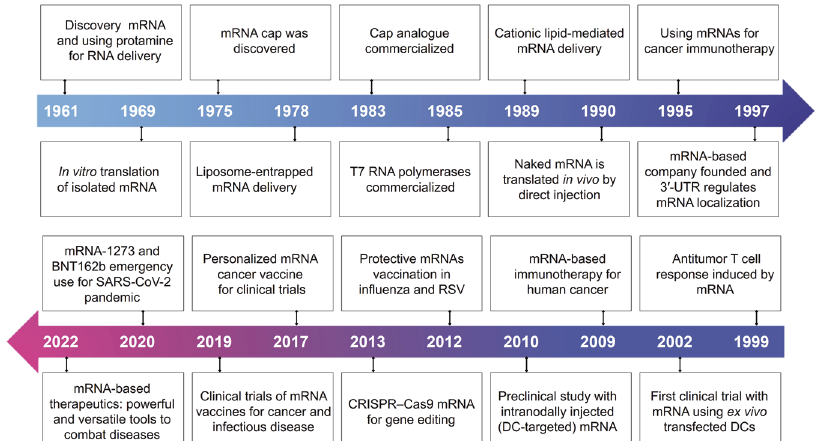
Fig. 1 Key discoveries and advances in mRNA-based therapeutics. The development of mRNA-based therapeutics can be divided into three stages. Phase 1, mRNA discovery, in vitro synthesis and nucleic acid delivery system construction (1961 – 1990), including discovery mRNA 523 and using protamine for RNA delivery, 524 in vitro translation of isolated mRNA, 525 mRNA cap was discovered, 526 Liposome-entrapped mRNA delivery, 527 Cap analog commercialized, T7 RNA polymerases commercialized, Cationic lipid-mediated mRNA delivery, 528 Naked mRNA is translated in vivo by direct injection. 529 Phase2 (1990-2019), accumulated knowledge with the continuous attempts and diverse applications, especially protein replacement therapies and vaccination approaches for cancer and infectious diseases, including using mRNAs for cancer immunotherapy, 5 mRNA-based company founded and 3 ′ -UTR regulates mRNA localization, 530 antitumor T cell response induced by mRNA, 531 fi rst clinical trial with mRNA using ex vivo transfected DCs, 532 mRNA-based immunotherapy for human cancer, 533 preclinical study with intranodally injected DC-targeted mRNA, 534 protective mRNAs vaccination in in fl uenza 240 and respiratory syncytial virus, 98 CRISPR – Cas9 mRNA for gene editing, 535 personalized mRNA cancer vaccine for clinical trials. 330 Phase 3, mRNA-based therapeutics, as a disruptive therapeutic technology, is becoming powerful and versatile tools for therapy diseases (2019 to present), including clinical trials of mRNA vaccines for cancer and infectious disease, mRNA-1273, 536 and BNT162b emergency use for SARS-CoV-2 pandemic